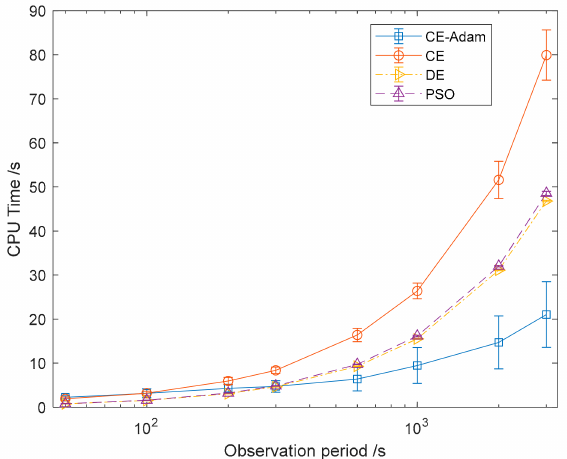
Figure 7. Comparison of central processing unit (CPU) time.